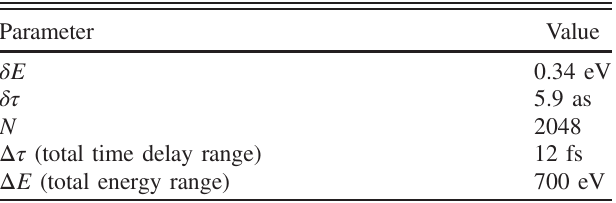
TABLE III. FROGCRAB